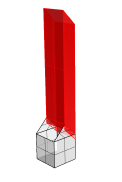
Figure 4. Illustration of the region of interest for a given roof surface